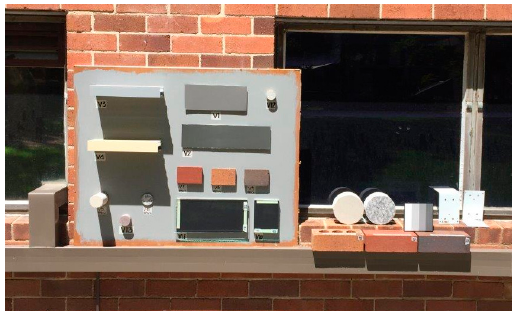
Figure 7. Plywood-mounted and full size validation samples and CBs.